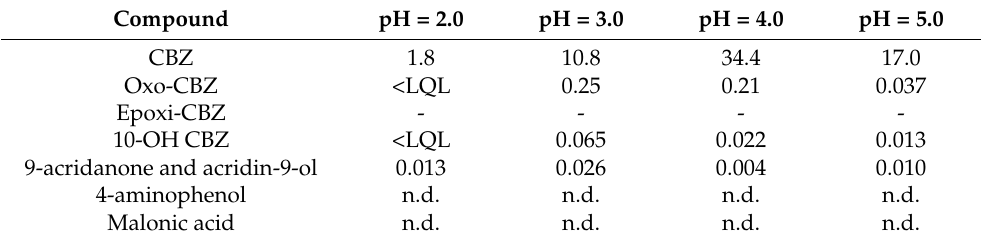
Table 2. Results of quantitative analysis, concentrations in µ g/mL.